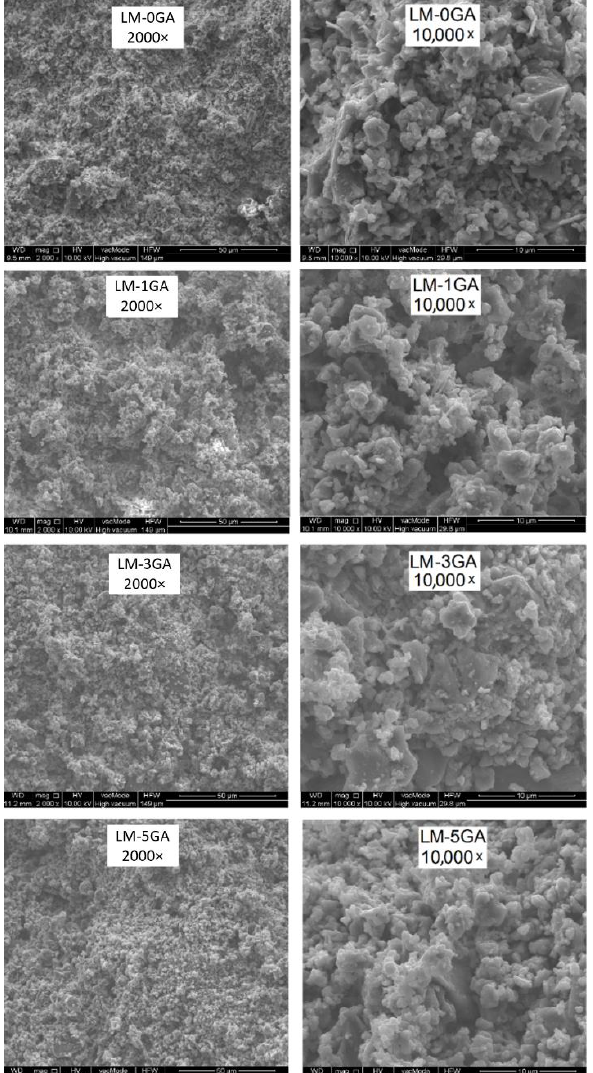
shown in Figure 5 and Figure 6, respectively. The total pore surface versus pore diameter Figure 4. SEM images of paste samples. Figure 4. SEM images of paste samples. curves is shown in Figure 7.